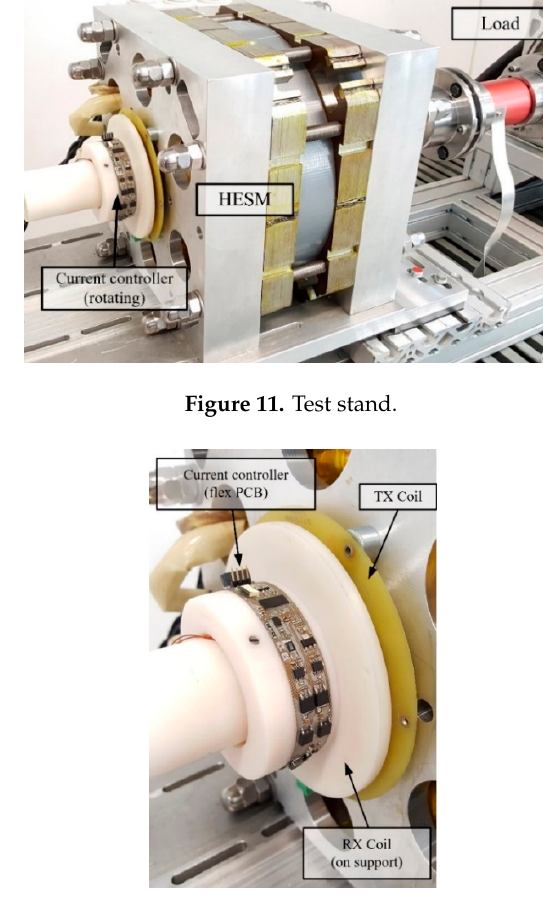
Figure 12. Coil current controller (on the rotor).